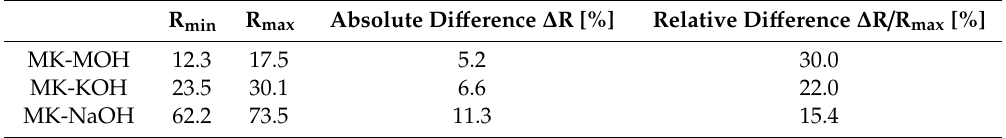
Figure 6. Degree of reaction calculated according to different approaches (Section 2.6). Table 9. Summary of the minimal (R min ) and maximal (R max ) degree of reaction, their absolute difference ( Δ R) and their relative difference ( Δ R/R max ).